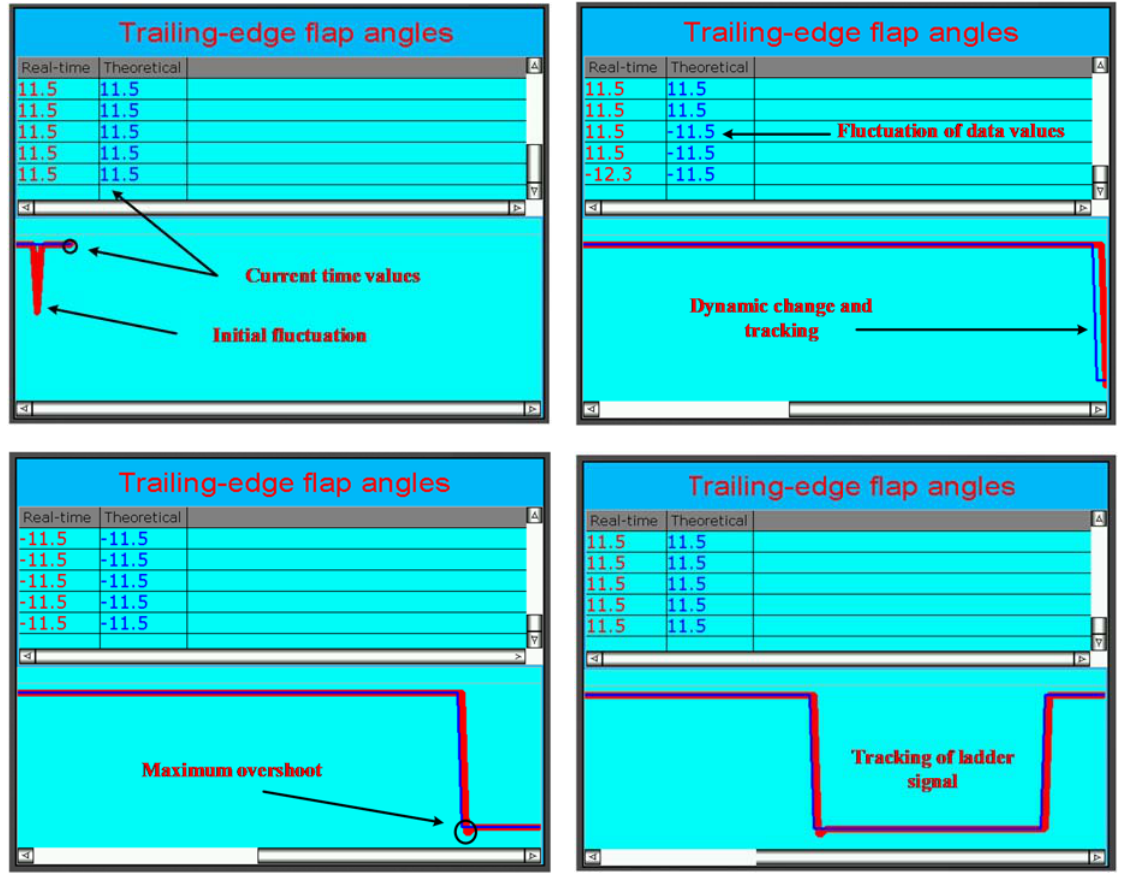
Figure 9. The physical tracking effect of trailing ‐ edge flap angles displayed in HMI.